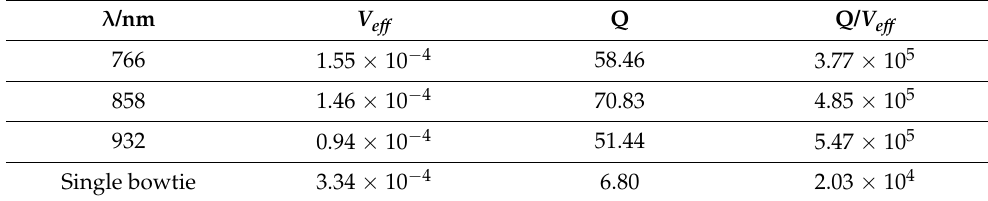
Table 1. Normalized effective mode volume, the quality factor and Q/V eff for different resonance modes of bowtie nanoholes, and a single disk upon silica spacer and silver film.